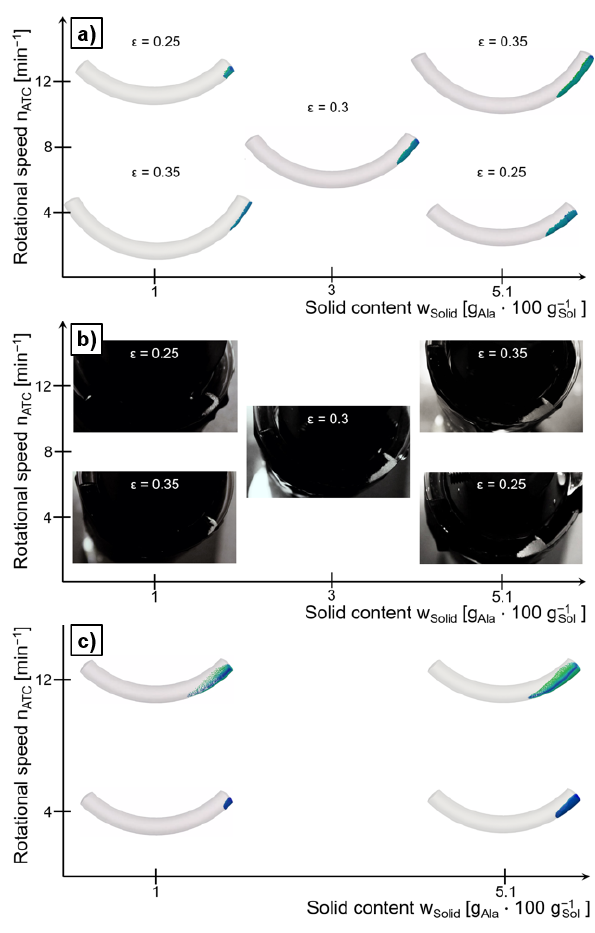
Figure 6. Suspension behavior observed ( a ) in CFD simulations with d p = 364 µ m at varying filling degrees (cid:101) , ( b ) in experiments with d mod = 364 µ m (sieve fraction 250–315 µ m) at varying filling degrees (cid:101) , and ( c ) in CFD simulations with d p = 182 µ m at filling degree (cid:101) = 0.25.